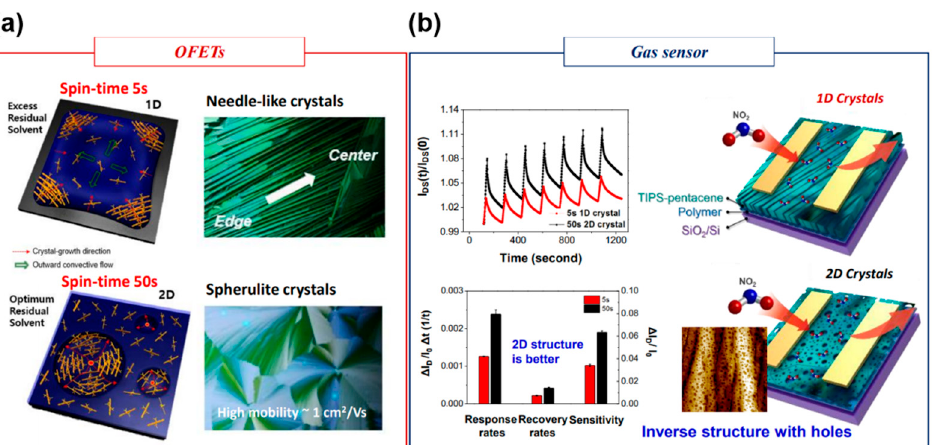
Figure 8. Spin-coating time (5 s or 50 s) governs the 1D versus 2D growth of TIPS-pentacene on a polymer, affecting the performance of FETs and gas sensors [37]. Copyright 2018 Wiley. ( a ) Mechanism and polarized optical microscopy images of TIPS-pentacene crystals and ( b ) NO 2 sensing performance and schematics showing the gas-sensing mechanism [37]. Copyright 2019 Nature Publishing Group.